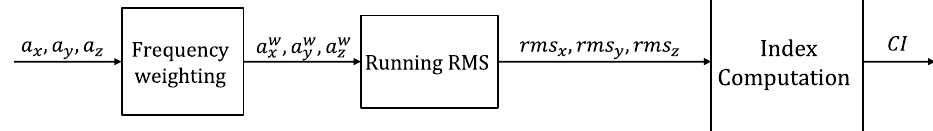
Figure 8. Block schemes representation of the Comfort Index estimation